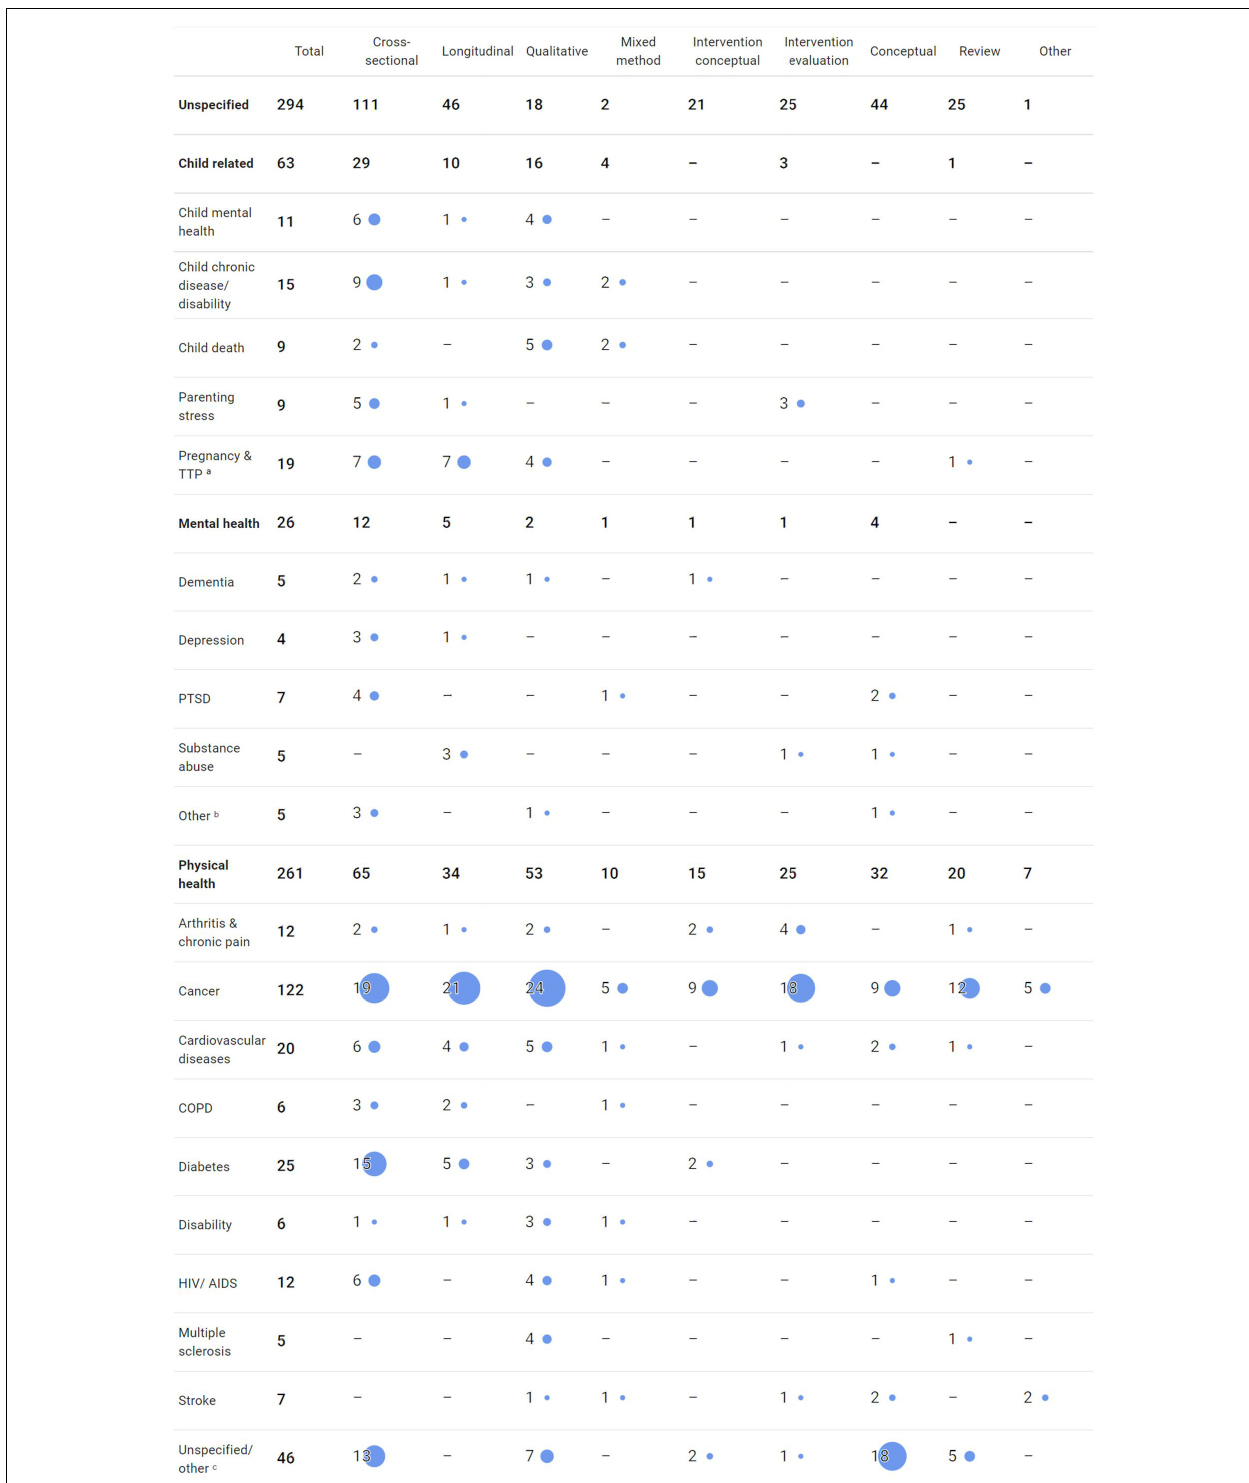
FIGURE 5 | Frequencies of dyadic coping (DC) publications organized by study design and stressor type between 1990 and 2020. a TTP, transition to parenthood. b The category “Mental health – Other” includes studies on eating disorders, general mental health condition, self-injury, and sexual functioning. c The category “Physical health – Unspecified/other” includes studies on cystic fibrosis, endometriosis, fibromyalgia, inflammatory bowel disease, kidney failure, lupus erythematosus, Parkinson’s disease, sleep disorder, and mixed or unspecified health conditions.